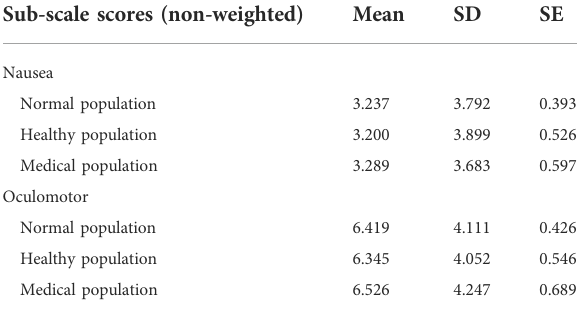
TABLE 5 SSQ sub-scale scores.